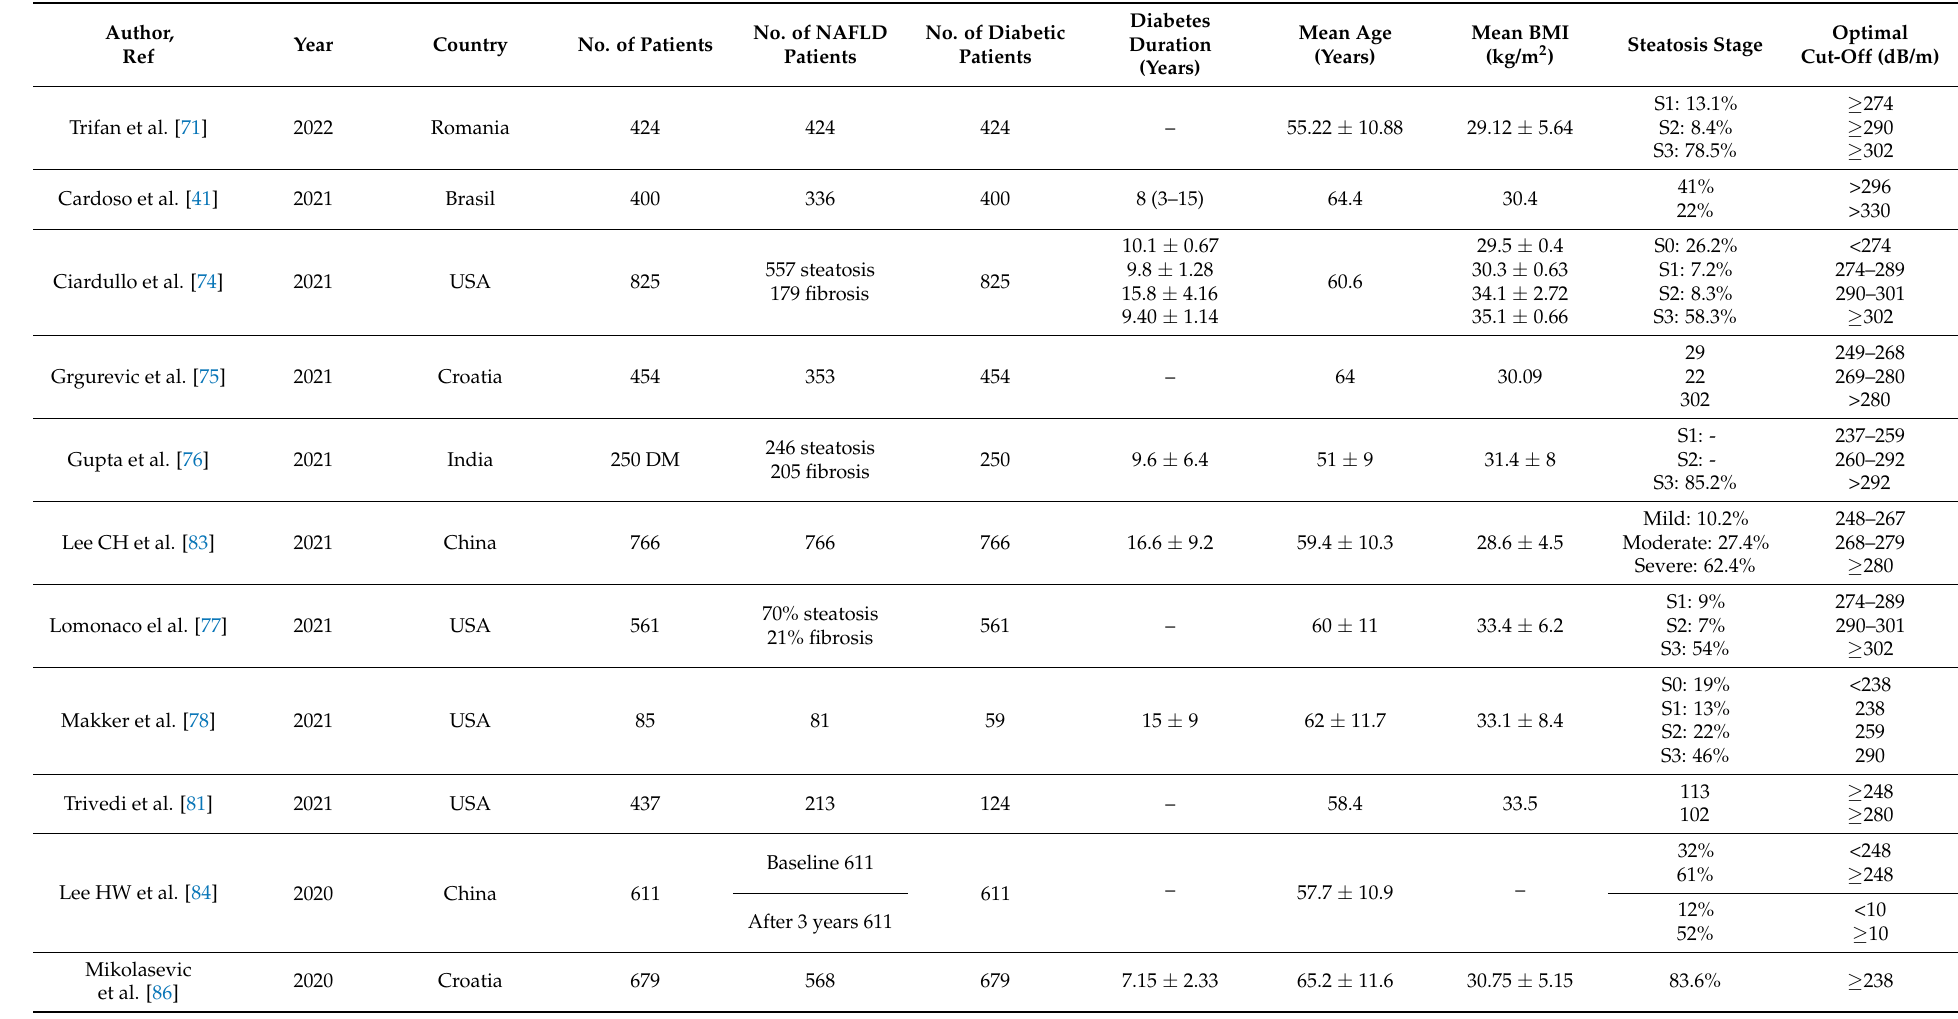
Table 4. Diagnostic performance and comparison of results for different steatosis degrees using CAP in patients with NAFLD and